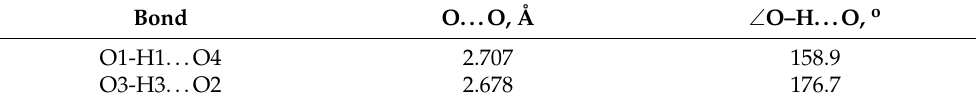
Figure 2. Crystal packing of 1 along (010) plane. Hydrogen O-H…O bonds are illustrated with dotted lines.